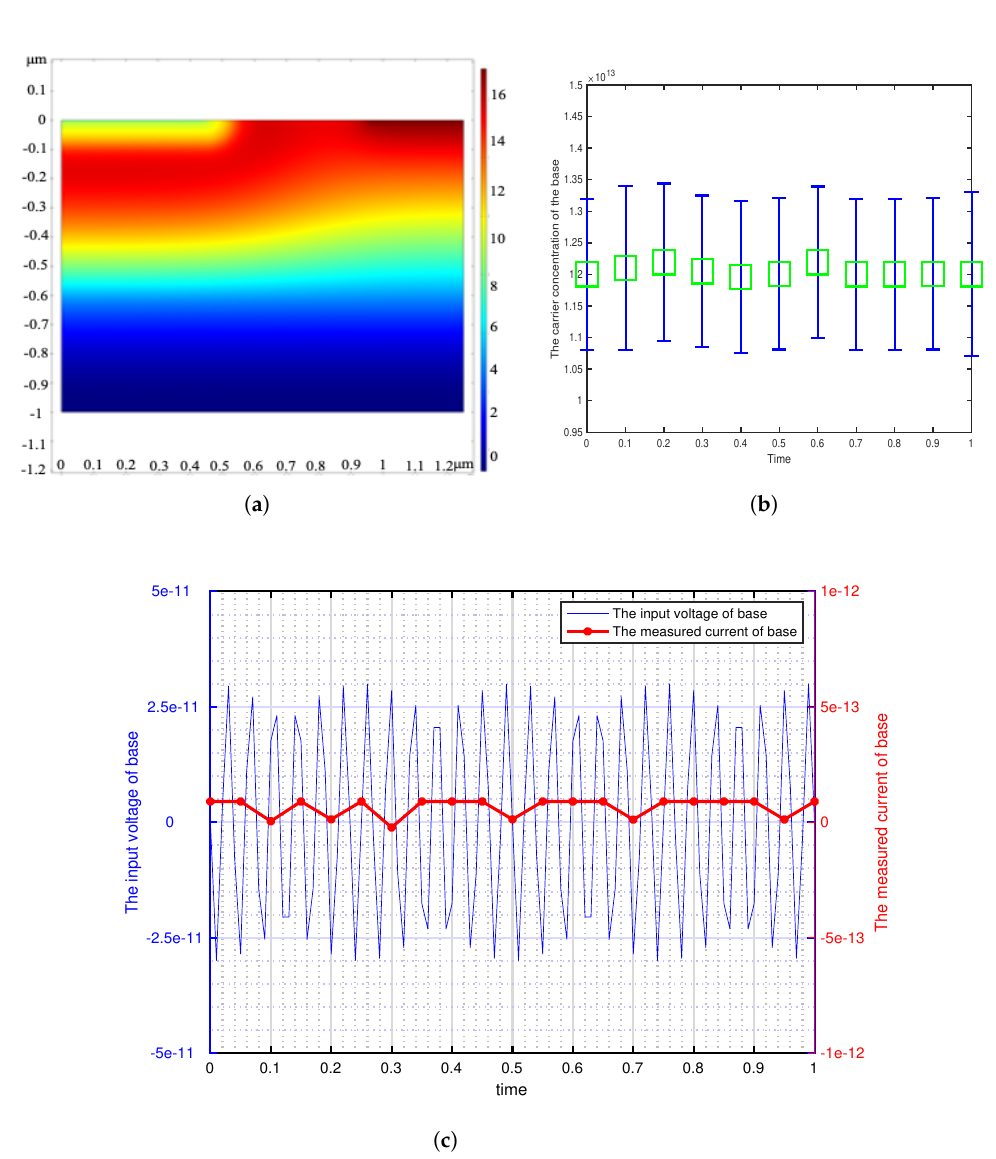
Figure 5. The corresponding sinusoidal voltage signal is applied to the bipolar transistor in the amplification region, which is made of impurity germanium (Ge-1) with doping concentration of 1.2 × 10 13 cm − 3 and carrier lifetime of 2 × 10 − 4 s. ( a ) The potential distribution of the intrinsic semiconductor under sinusoidal small voltage signal. (2-D front view) ( b ) The variation of base carrier concentration with time. ( c ) The input weak sinusoidal voltage signal and corresponding base current